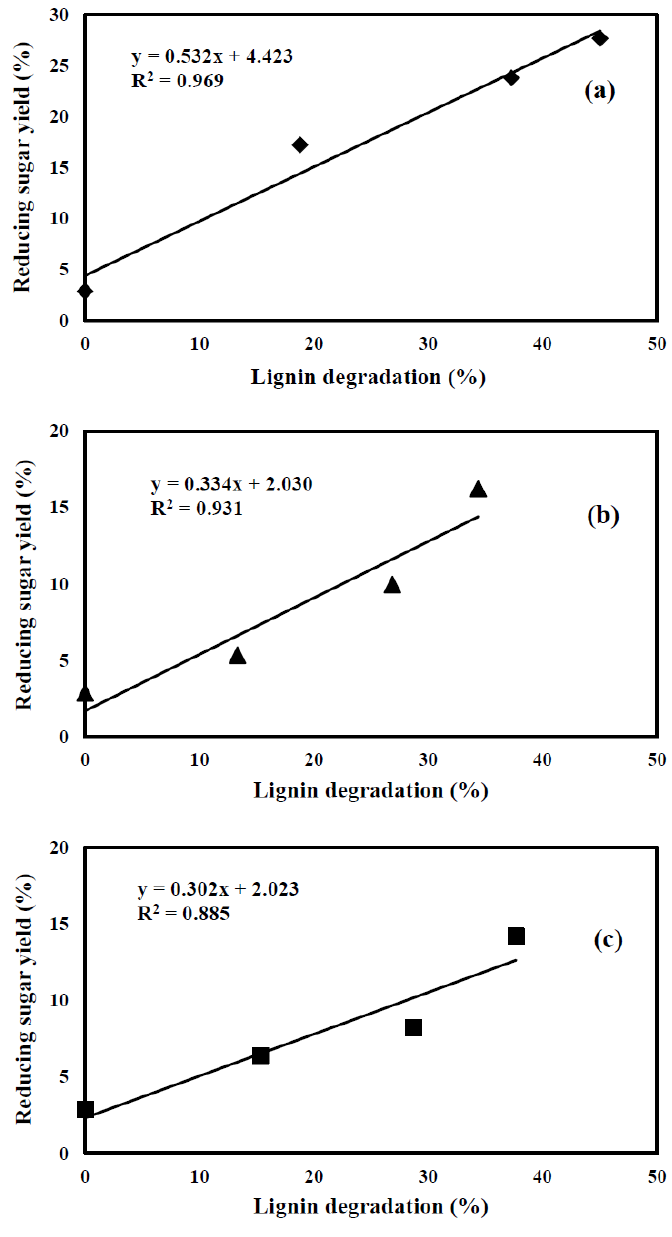
Figure 5. Effect of lignin degradation on enzymatic hydrolysis of rubberwood pretreated with ( a ) C. subvermispora ; ( b ) T. versicolor ; ( c ) mixed culture. Reducing sugar yield (%) was obtained after 168 h enzymatic